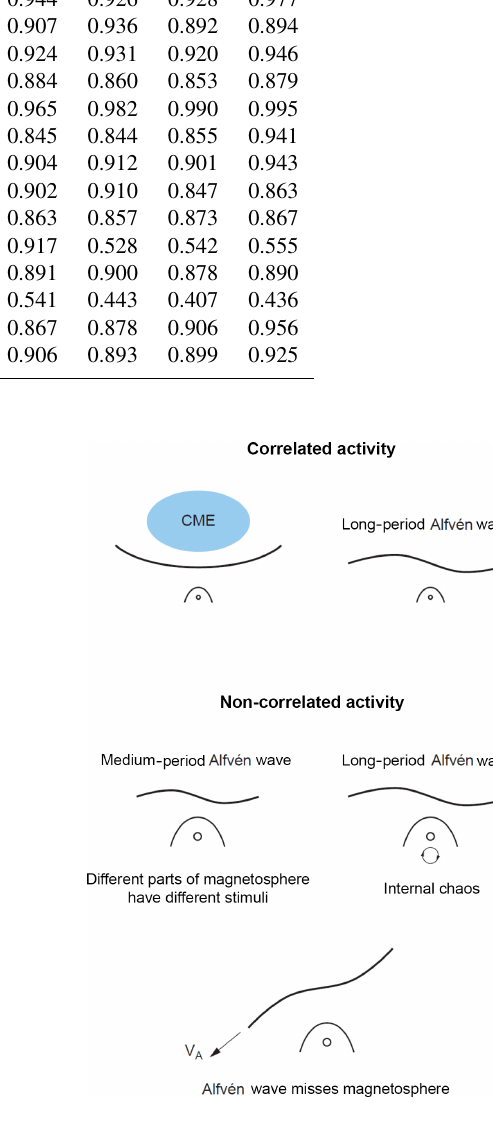
Figure 4. Schematic showing the possible causes for correlated and uncorrelated events between interplanetary parameters and geomag- netic